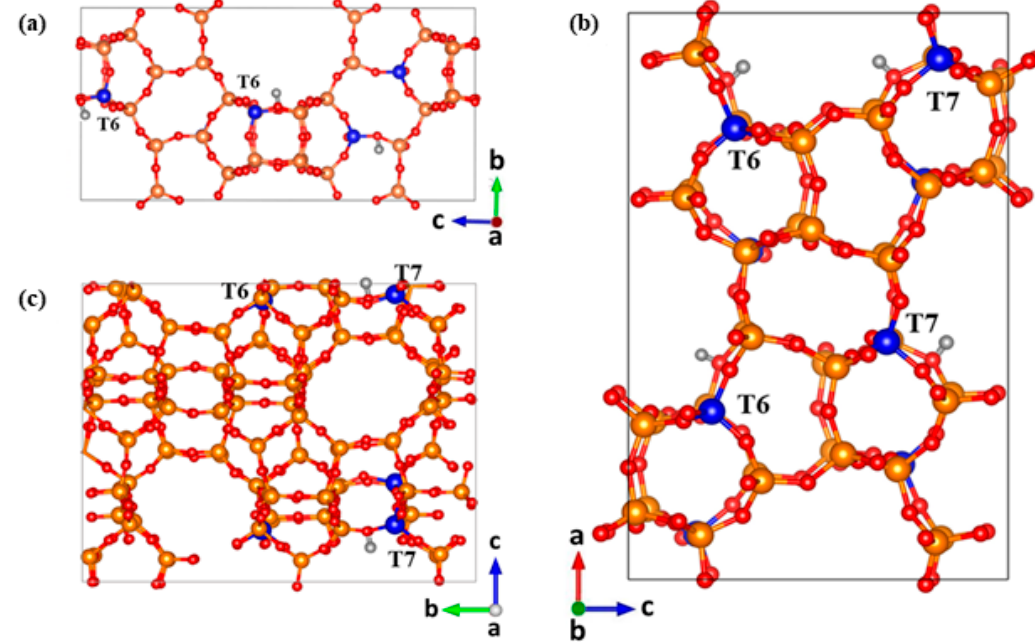
Figure 7. ( a ) Zeolite Beta with substituted Al at tetrahedral site T6 and proton on O12. Zeolite MFI showing the substituted Al at ( b ) T7 and T6 with protons on O17 and O13 for straight and the intersection between channels, respectively and ( c ) site T7 with proton on O18 for the sinusoidal channel. Element color code: O (red), Si (orange), Al (blue), H (gray).